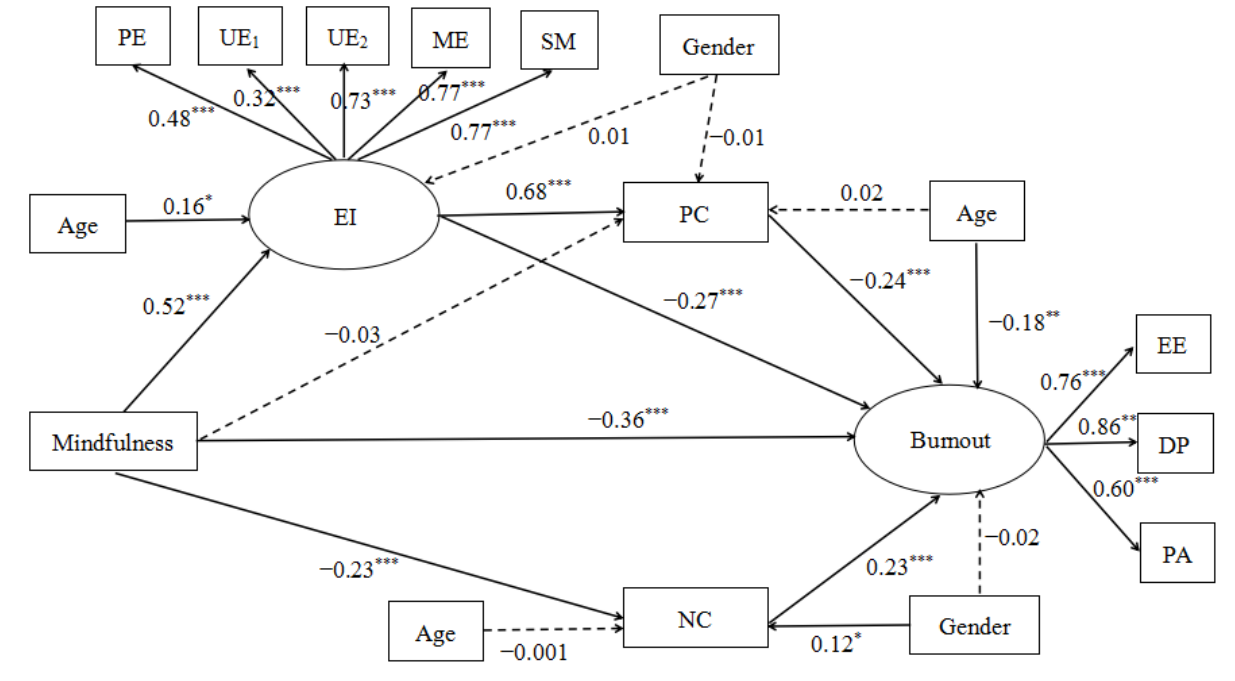
Figure 2. The chain mediation model. Note: * p < 0.05, ** p < 0.01, *** p < 0.001. EI = emotional intelligence, PC = positive coping style, NC = negative coping style, PE = perceiving emotion, UE 1 = use of emotion, UE 2 = understanding emotion, ME = managing emotion, SM = social manage- ment, EE = emotional exhaustion, DP = depersonalization, PA = personal